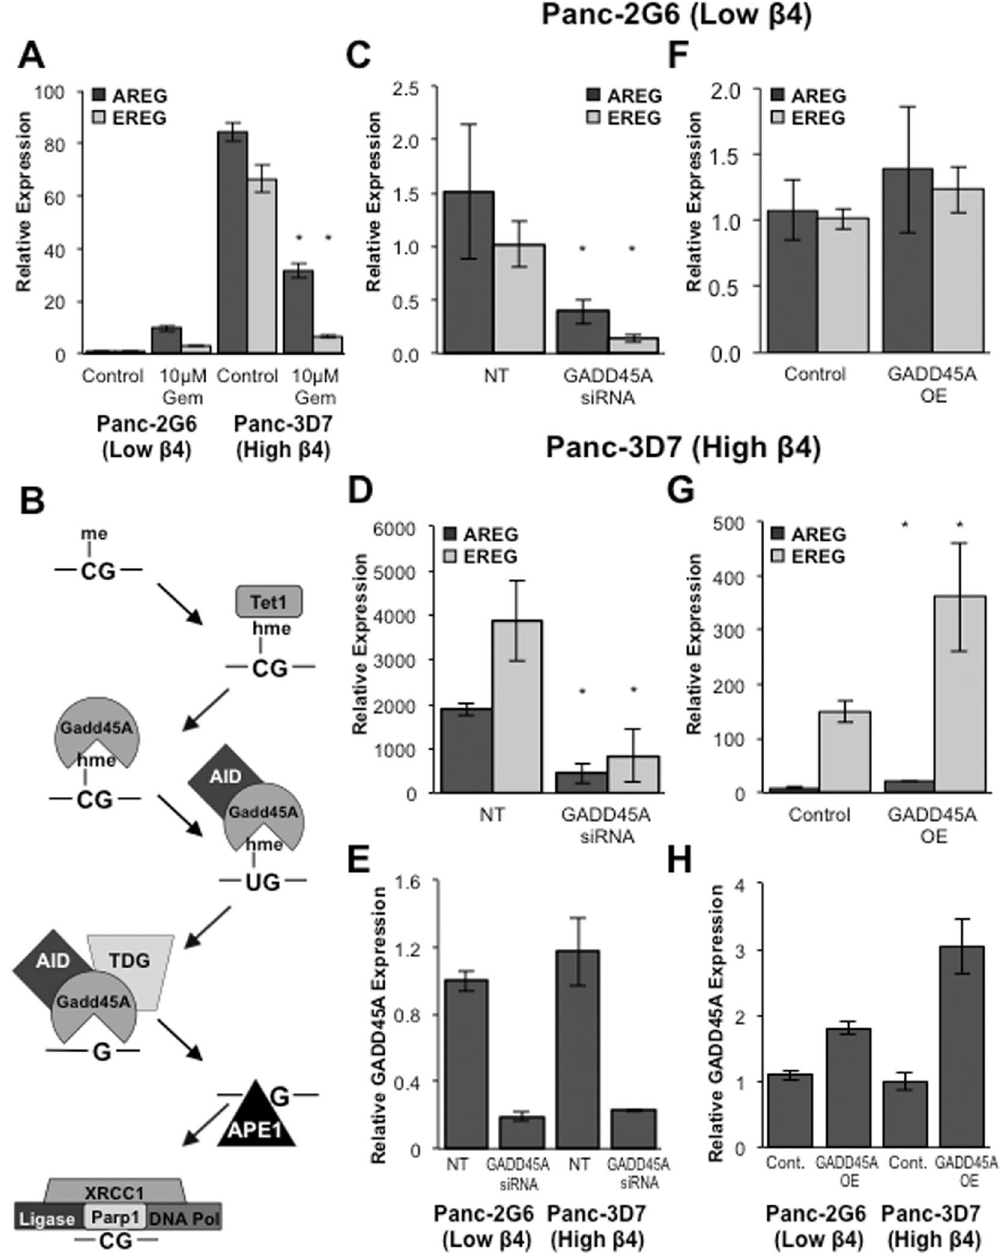
Figure 5. GADD45A is both required for and the rate-limiting step in activation of AREG and EREG expression. ( A ) Cells were treated with 10 μ M Gemcitabine for 72 hours and expression of AREG and EREG measured by QPCR. ( B ) Summary of current literature for how GADD45A mediated DNA demethylation is achieved. Transient knockdown of GADD45A was achieved using electroporation and specific siRNA ( E ). Adenovirus was used to overexpress GADD45A in Panc1-2G6 and Panc1-3D7 cells ( H ). Changes in AREG and EREG expression were measured by QPCR in Panc1-2G6 ( C , F ) and Panc1-3D7 ( D , G ). Data depicted here are representative of at least three different experiments and represent the mean + / − standard deviation. Statistical significance was calculated using a one-tailed t-test in which * denotes P < 0.05 as compared to